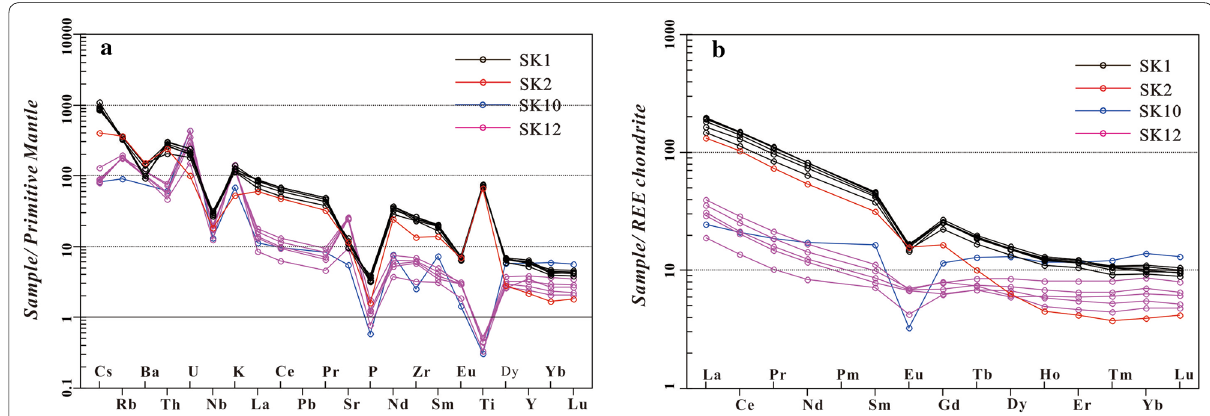
Fig. 12 Primitive-mantle-normalized multi-element variation diagram ( a ) from Sun and McDonough (1989) and chondrite-normalized REE patterns ( b ) from Boynton (1984) of augengneisses and leucogneisses from the Pohorje